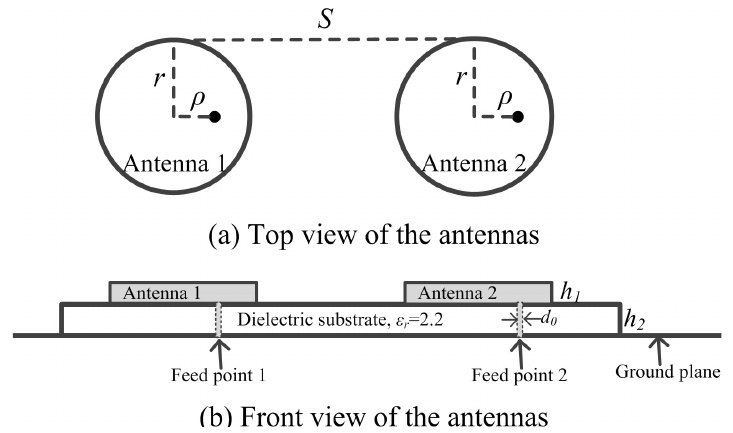
Figure 10. The dimension of antennas used to evaluate the mutual coupling effect, where r = 51.75 mm, ρ = 21.11 mm, h 1 = 0.1 mm, h 2 = 1.575 mm, d 0 = 0.65 mm.